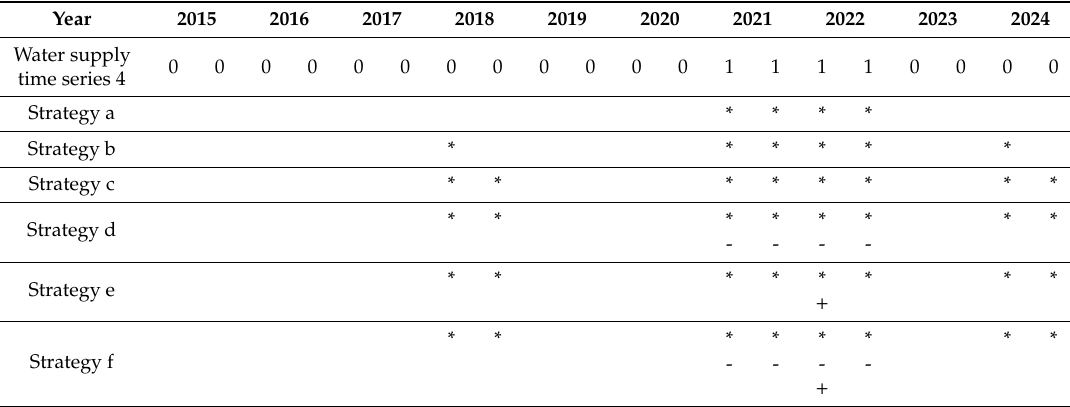
Table 5. Timeframe of water demand management policies in each strategy